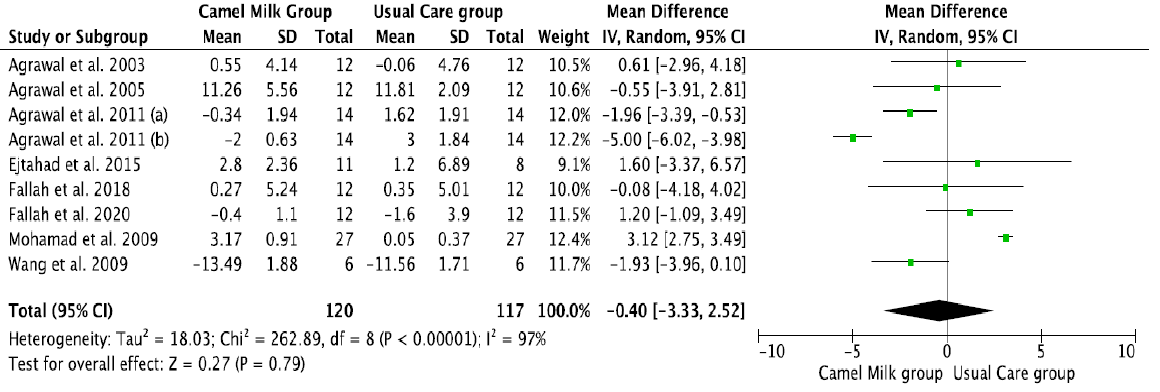
Figure 6. Forest plot for the effect of CM intake on fasting serum insulin (FI). (a) and (b) are two different studies (difference between the two articles that are published by same author (Agrawal), same year).